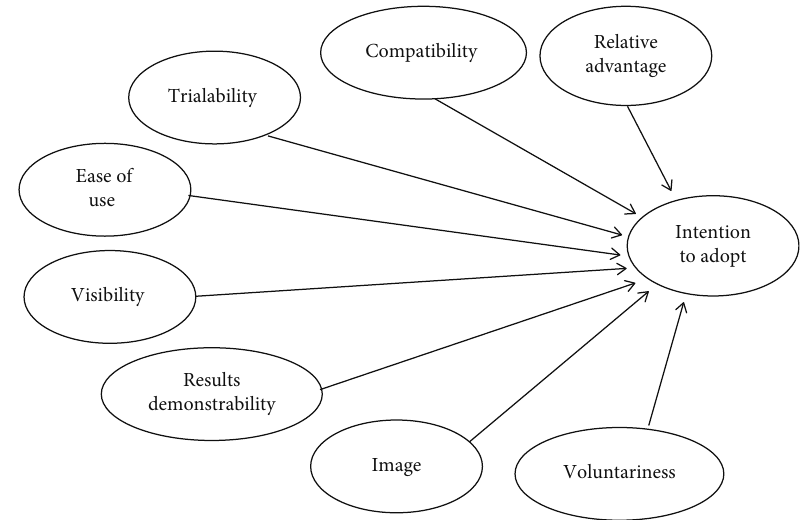
Figure 17: Perceived characteristics of innovating theory [44].